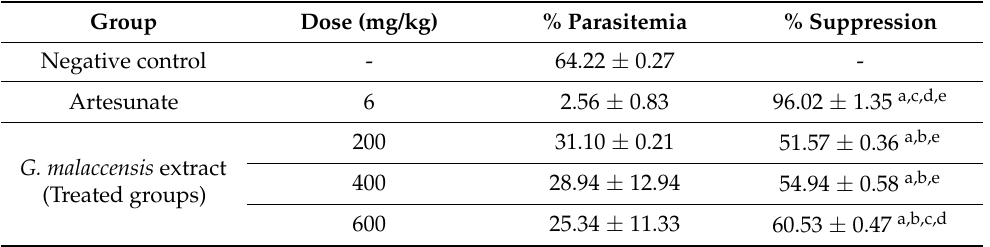
Table 5. Effects of the ethanolic extracts of G. malaccensis on the percent parasitemia in Plasmodium berghei -infected mice in the 4-day suppressive test.